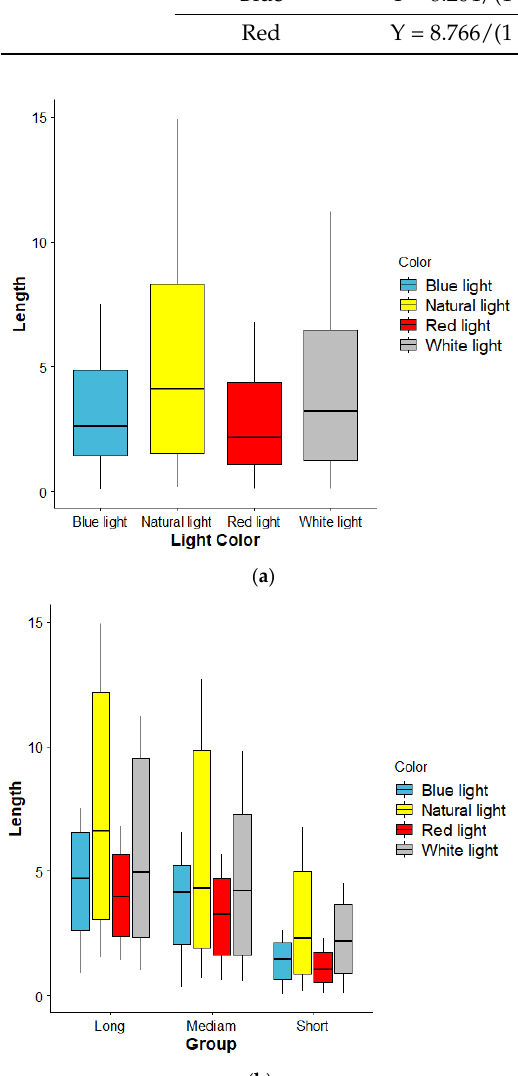
Figure 10. Comparison of the effects of the four light spectra on the length of hypocotyls ( a ) and comparison of the effect between length groups ( b ).